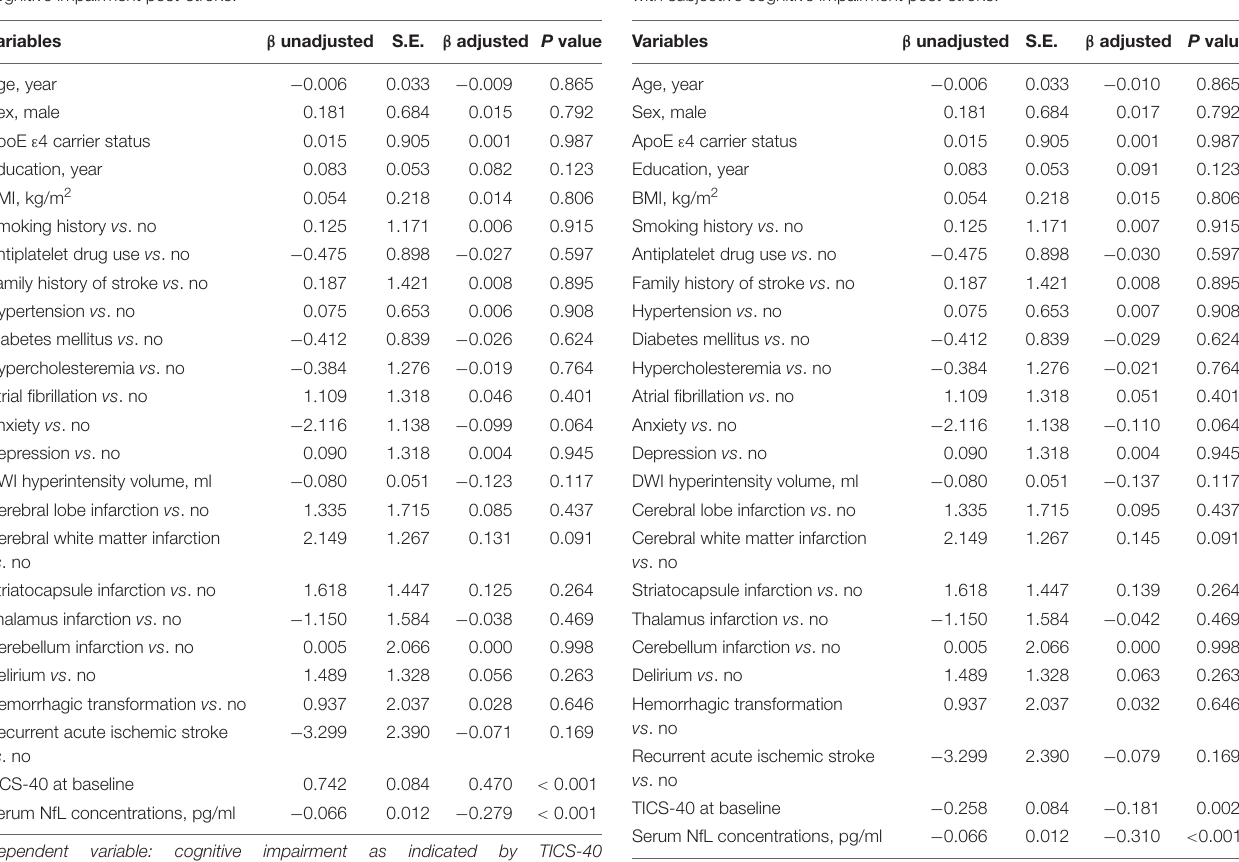
TABLE 4 | A linear regression model to evaluate the risk factors for cognitive decline as indicated by a change of TICS-40 scores during follow-up in patients with subjective cognitive impairment